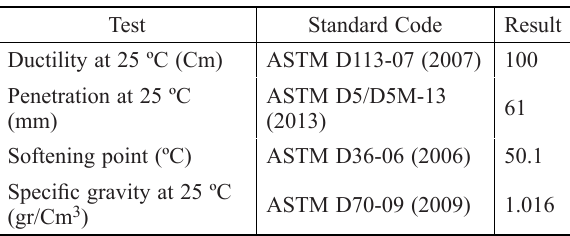
Table 1. Physical and mechanical properties of 60/70 pen asphalt